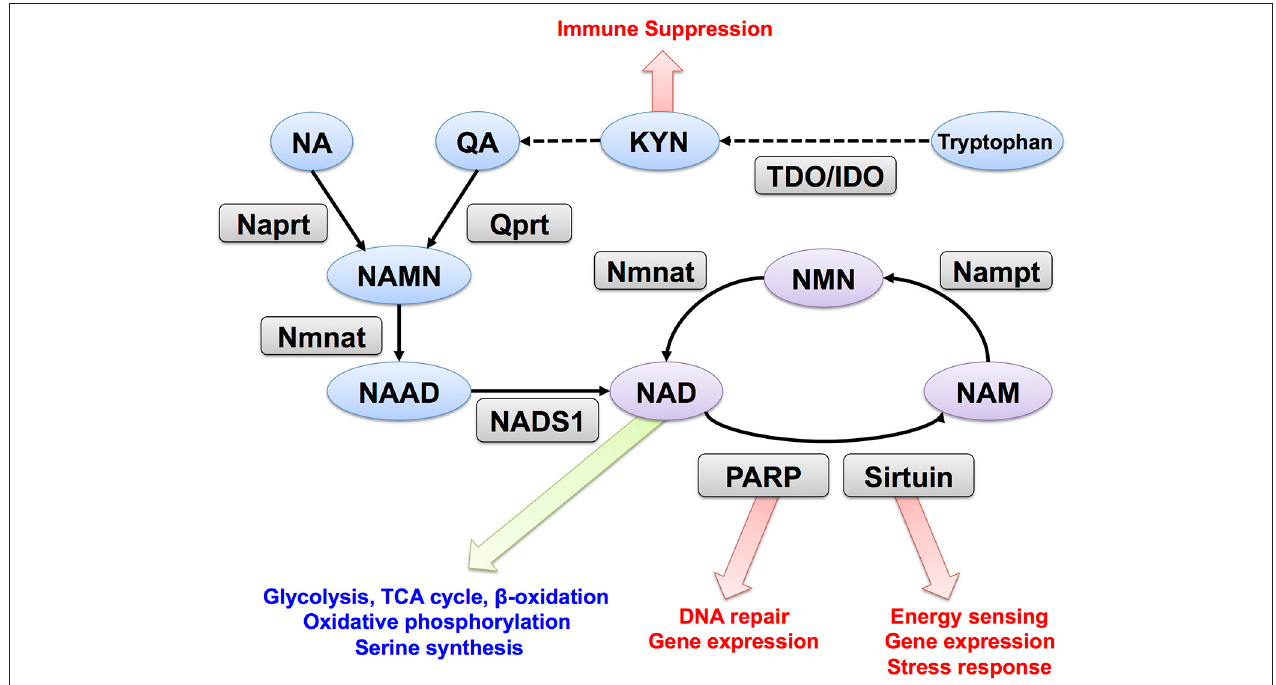
FIGURE 1 | NAD metabolism and its downstream targets. Trp, tryptophan; KYN, kynurenine; NA, nicotinic acid; NAM, nicotinamide; QA, quinolinic acid; NMN, nicotinamide mononucleotide; NAMN, nicotinic acid mononucleotide; NAD, Nicotinamide adenine dinucleotide; NAAD, nicotinic acid adenine dinucleotide; Nampt, nicotinamide phosphoribosyltransferase; Nmnat, nicotinamide mononucleotide adenylyltransferase; Qprt, quinolinic acid phosphoribosyltransferase; Naprt, nicotinic acid phosphoribosyltransferase; NADS1, NAD synthetase; PARP, poly (ADP-ribose) polymerase. TDO, tryptophan 2,3-dioxygenase; IDO, indoleamine